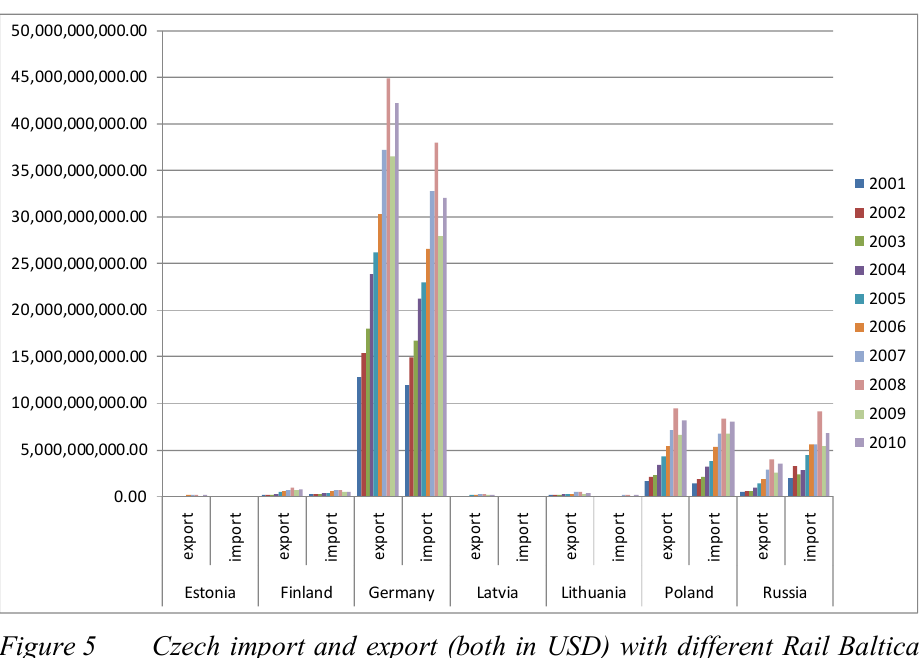
Figure 5 Czech import and export (both in USD) with different Rail Baltica Growth Corridor countries during period of 2001-2010. Source: United Nations (2011)